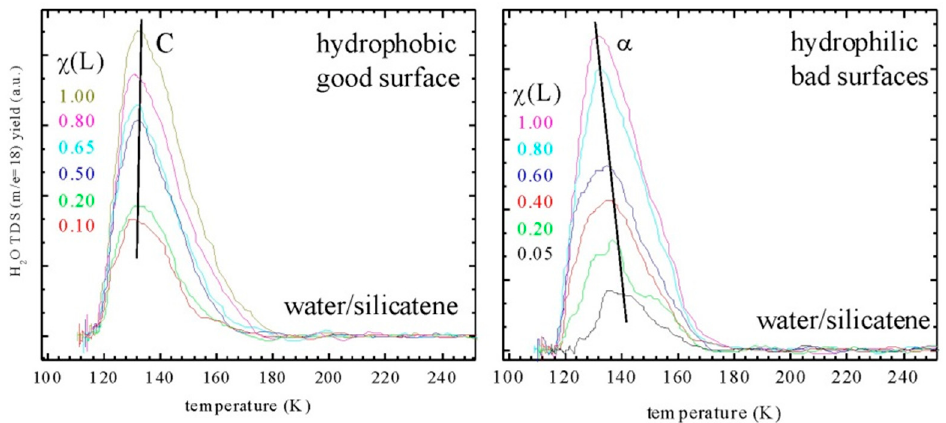
Figure 2. TDS of water on silicatene/Mo(112). Results of two different silicatene preparations (two samples) are shown. C denotes the condensation peak (C-peak) and α : a monolayer peak (molecular adsorption) ( α -peak). Only the most important sub-monolayer exposure range is shown. (Data from